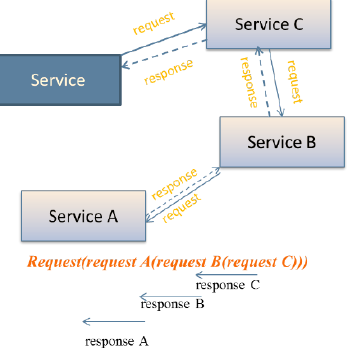
Figure 3. Cascaded Service chaining pattern